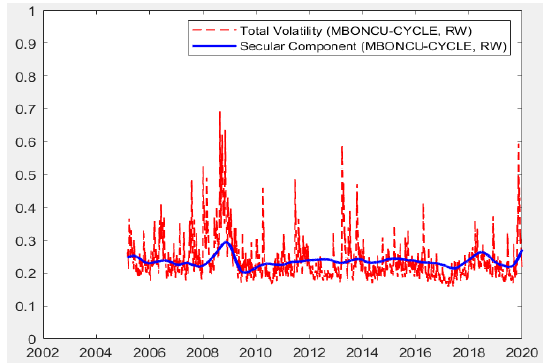
Figure 4. Total Variance and Long-Run Component with IPI-Cycle.